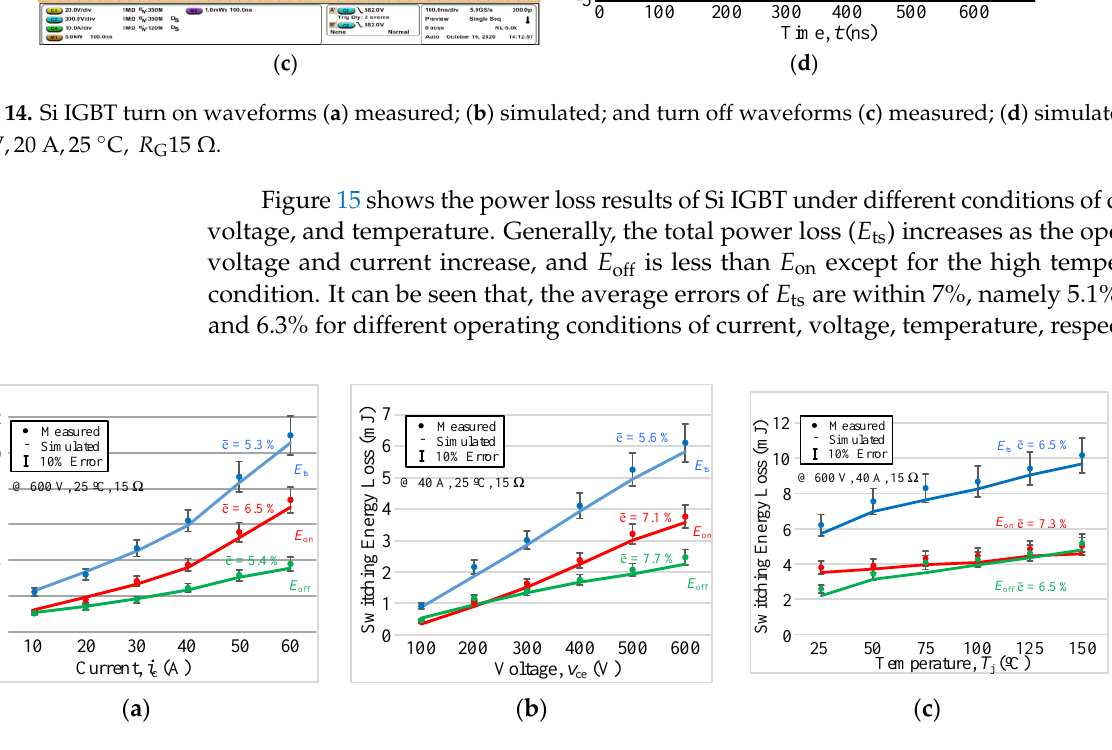
Figure 15. Si IGBT loss results under different values of ( a ) current; ( b ) voltage; ( c ) Temperature.